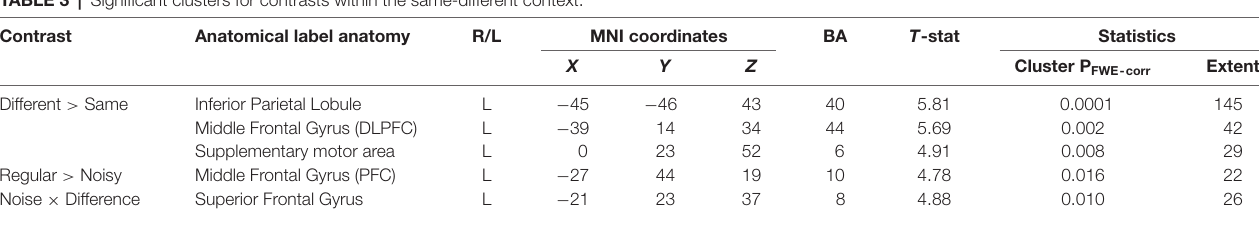
TABLE 3 | Significant clusters for contrasts within the same-different